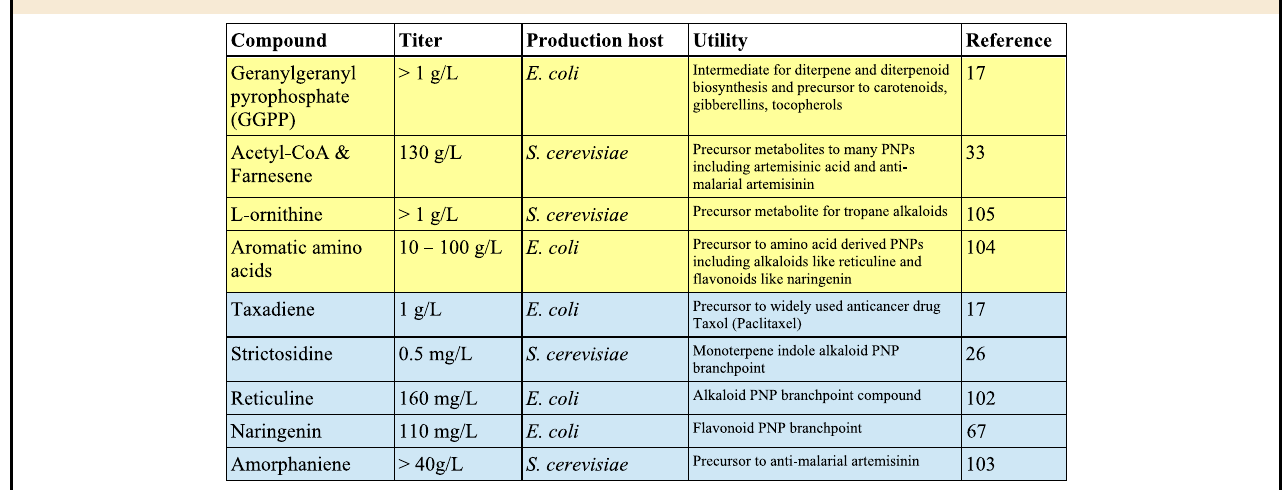
Table 1 Common platform strains a